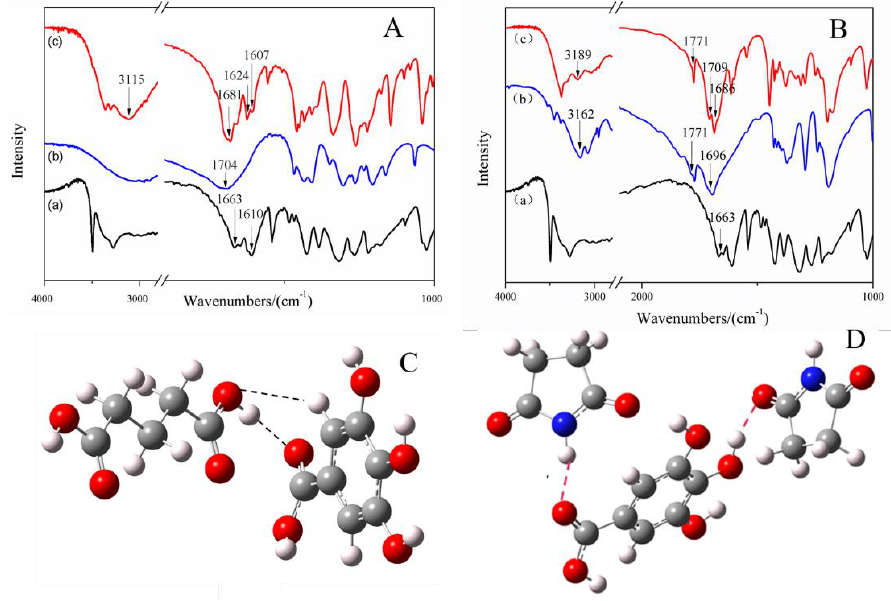
Figure 3. IR spectra of the GA, CCFs and their cocrystals ( A,B ) and simulated plausible models of the interactions (hydrogen bonds are marked using dashed lined) between GA and CCF cocrystals ( C,D ). Modeling was conducted using a GAUSSIAN-03 program package at the DFT B3lyp/6-31**level A, B: ( a ) GA; ( b ) CCF (glutaric acid in A and succinimide in B); ( c ) cocrystal.